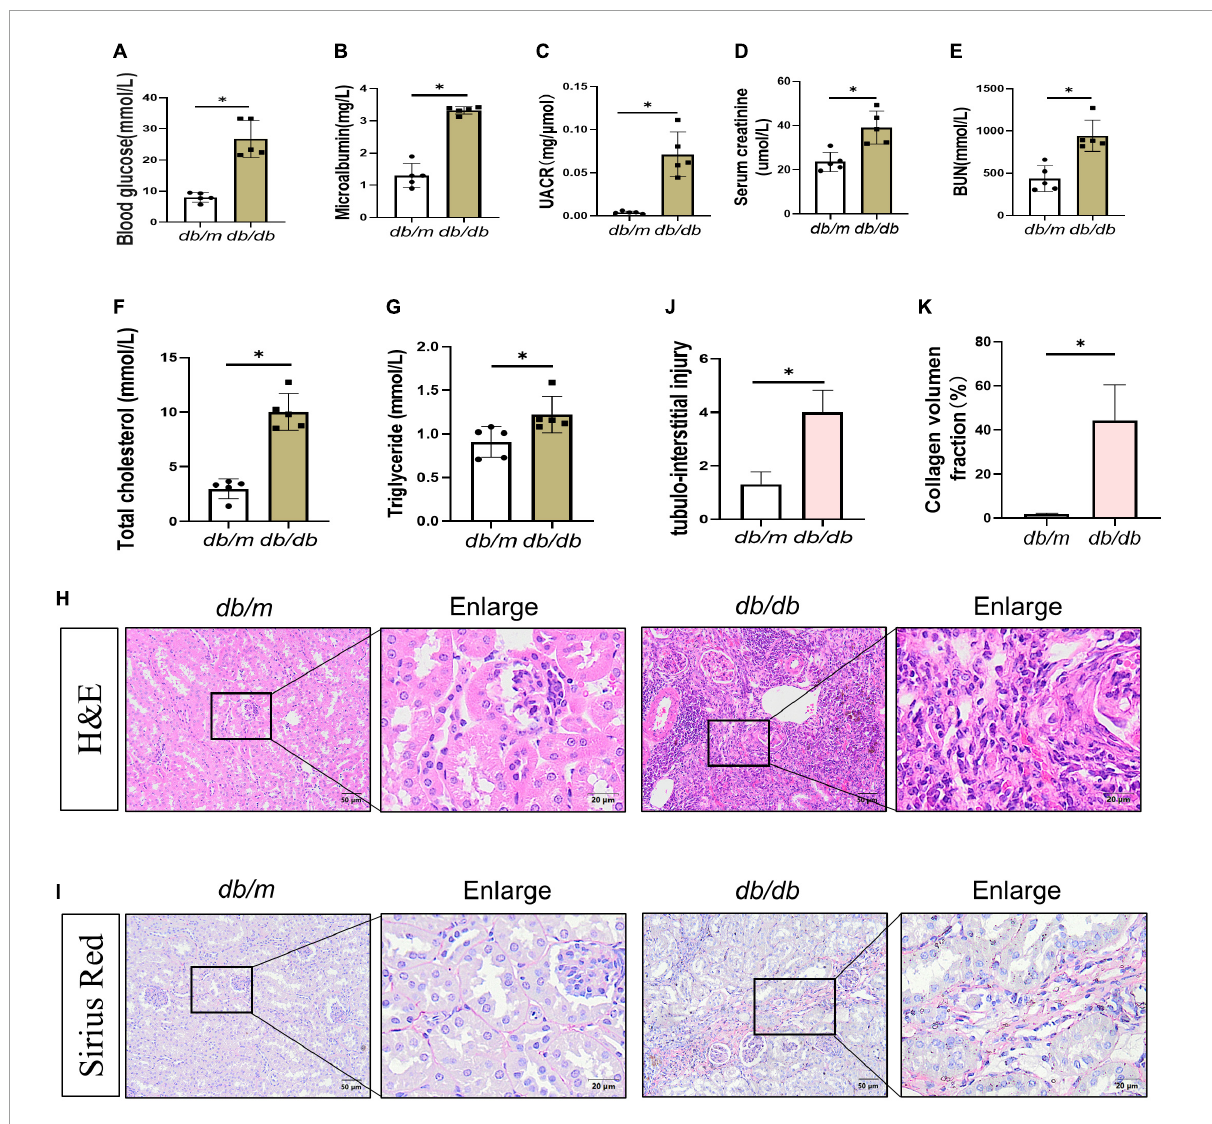
FIGURE1 Changes in biochemical indexes and renal morphology in db/db mice. (A–E) Blood glucose (A) , microalbumin (B) , UACR (C) , serum creatinine (D) , blood urea nitrogen (E) , total cholesterol (F) , and triglyceride (G) levels were increased. H&E staining (H) showed kidney histologic changes in db/db mice and db/m mice at 36 weeks and to assess the tubular injury index (J) . Bar = 50 µ m. Boxed areas are enlarged. Bar = 20 µ m. (I,K) Sirius red staining (SR) showed collagen deposition in db/db mice kidneys at 36 weeks (I) , collagen deposition fraction (K) . Boxed areas are enlarged. Bar = 20 µ m. All data are presented as mean ± standard deviation (SD) from three independent experiments. n = 5; ∗ P < 0.05 vs. db/m